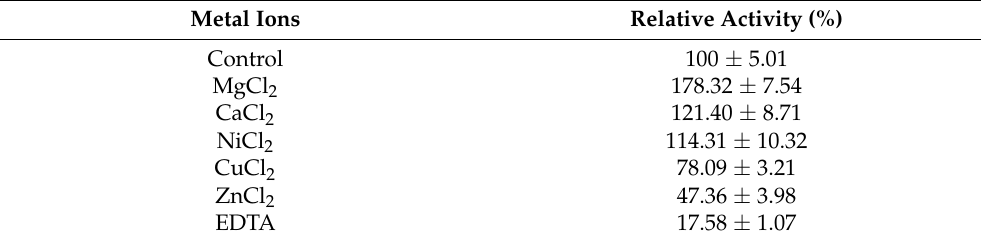
Table 4. Relative activity of MD2-SBro in the presence of various metal ions and EDTA.